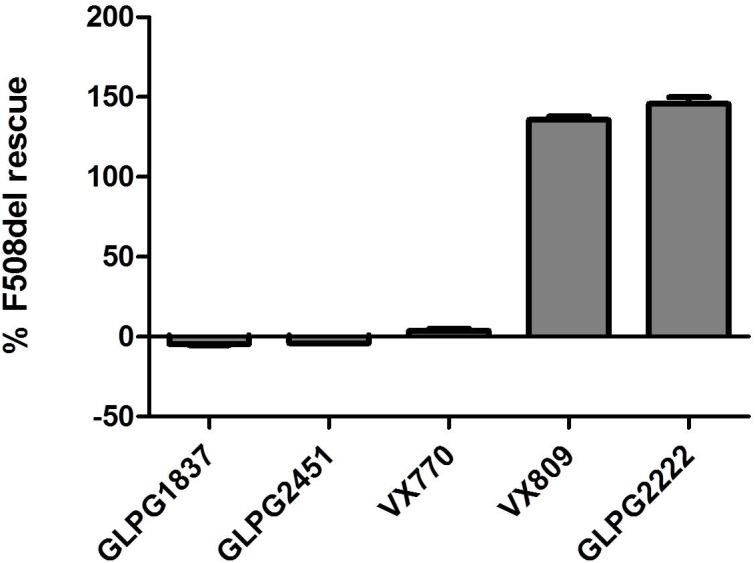
Cell Surface Expression assay: Rescue of HRP-tagged F508del CFTR in CFBe41O- cells was evaluated in presence of (from left to right), 10 μM GLPG1837, GLPG2451, VX770, VX809, or GLPG2222. Percent of cell surface rescue of F508del CFTR was calculated using an internal reference compound 15 (derived from same chemical series as GLPG2222). (n between 1 and 155 for different samples).